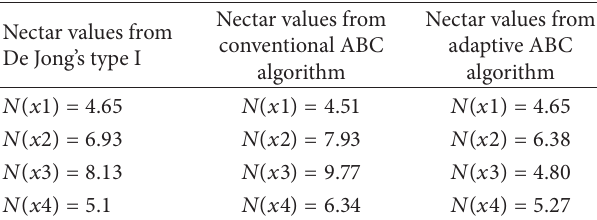
Table 2: Computed nectar